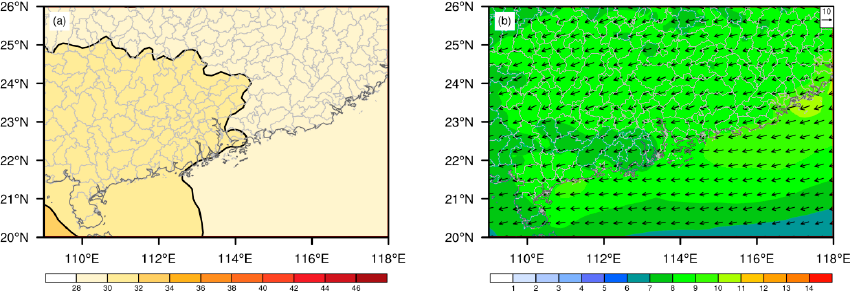
Figure 7. ( a ) Potential pseudo-equivalent temperature (shaded and black contours, unit: °C) and ( b ) vertical wind shear (shaded and arrows, unit: m ∙ s − 1 ) at 1000–700 hPa in Guangdong from April to June.